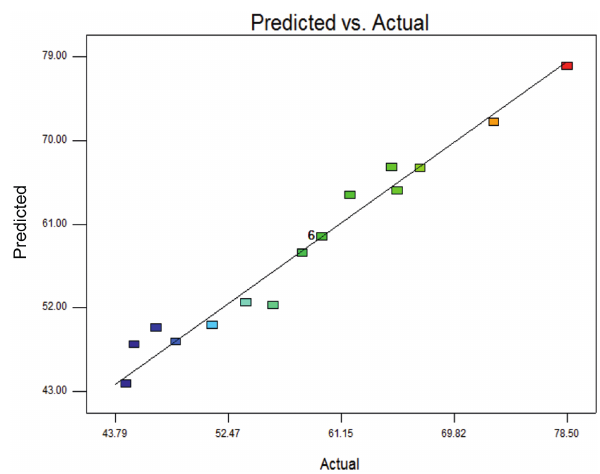
Figure 4: Predicted vs experimental yield of